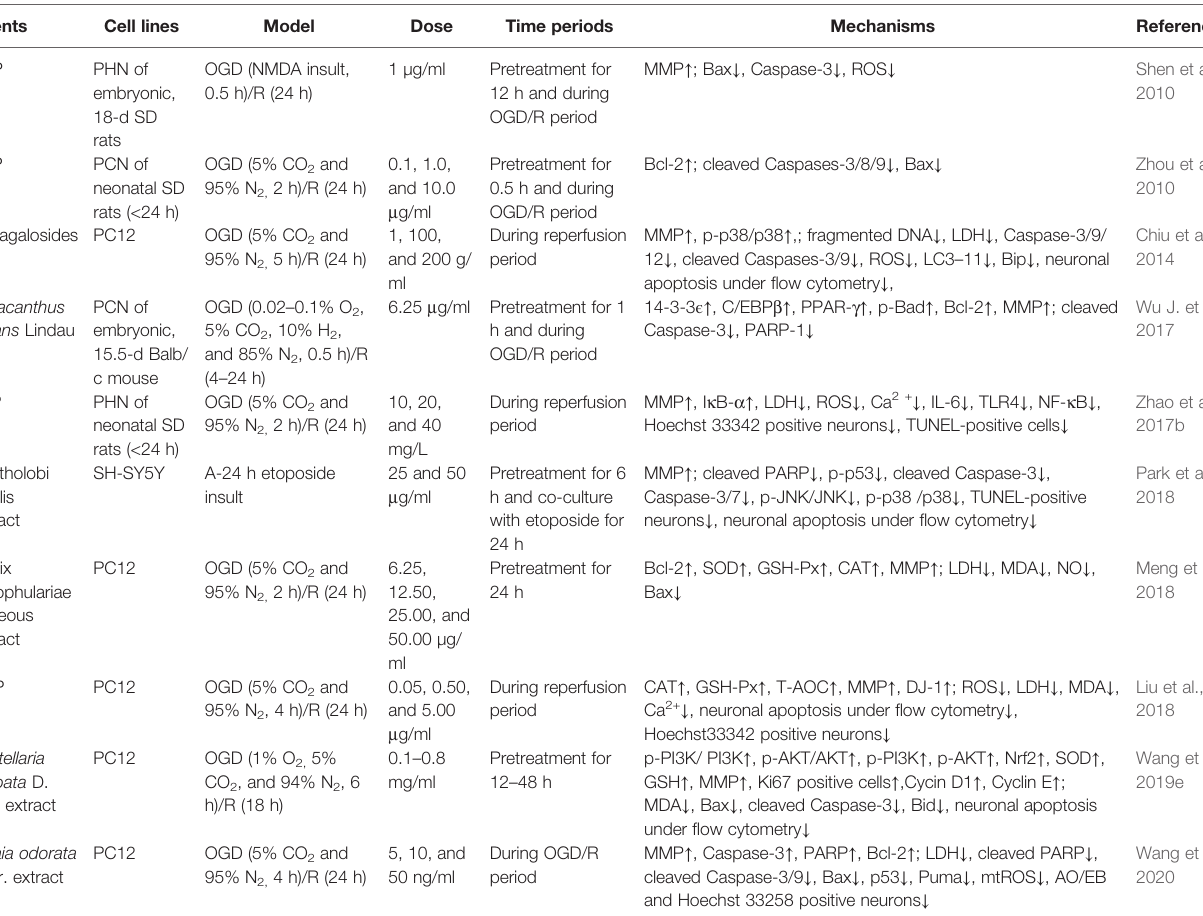
TABLE 5 | The in vitro mechanism underlying the inhibition of MPTP opening-induced neuronal apoptosis by herbal medicine in the treatment of ischemic stroke.